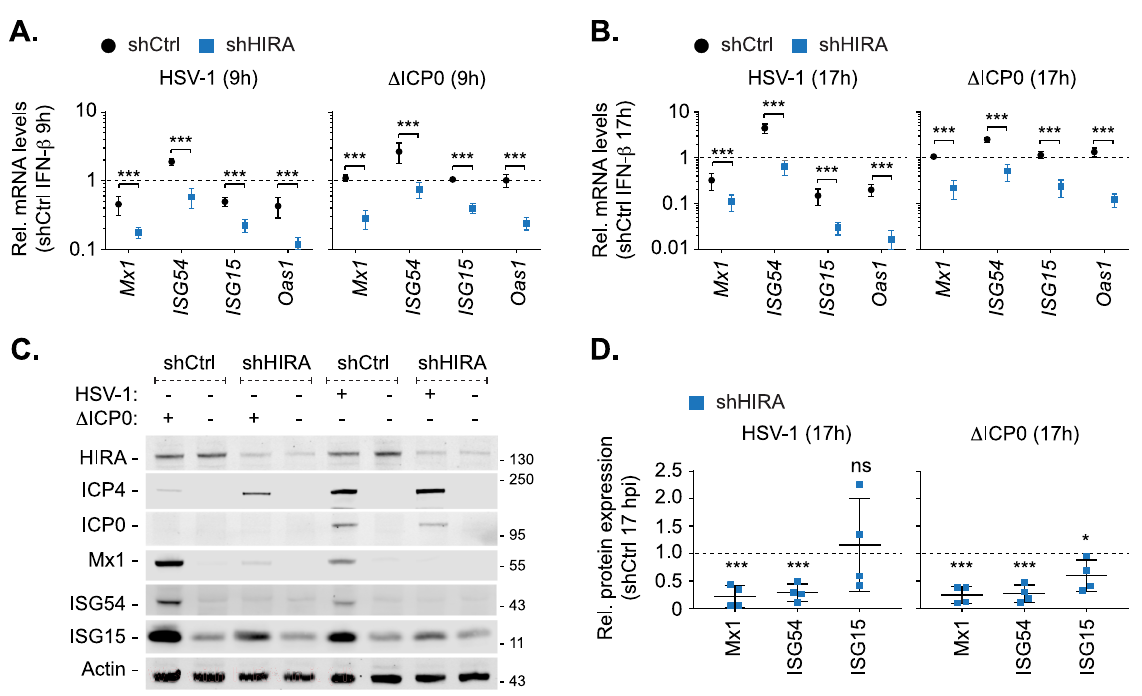
Fig 7. HIRA is required for efficient ISG expression during HSV-1 infection. HFt cells were stably transduced to express non-targeting control (shCtrl) or HIRA-targeting (shHIRA) shRNAs. Cells were stimulated with IFN- β or infected with 1 PFU/cell of WT or Δ ICP0 HSV-1 for 9 or 17 h (as indicated). (A, B) qRT-PCR quantitation of Mx1 , ISG54 , ISG15 , and OAS1 mRNA levels in shCtrl or shHIRA cells infected with WT or Δ ICP0 HSV-1 (as indicated) at 9 or 17 hpi (A and B, respectively). n = 3, means and SD shown. Values expressed relative to shCtrl + IFN- β at either 9 or 17 h (1; dotted line). ��� P < 0.001; two-tailed t-test. (C) shCtrl or shHIRA cells were mock infected or infected with 1 PFU/cell of WT or Δ ICP0 HSV-1 for 17 h. Whole cell lysates were analysed by western blot for HIRA, viral IE proteins (ICP0, ICP4), ISG (Mx1, ISG54, ISG15) expression levels, and actin (as a loading control). Molecular mass markers are shown. (D) Quantitation of ISG expression levels (as in C). n = 4, means and SD shown. Values normalized to their respective actin loading controls and expressed relative to their normalized levels in mock infected shCtrl cells (1; dotted line). � P < 0.05, �� P < 0.01, ��� P < 0.001, ns (not significant); two-tailed t-